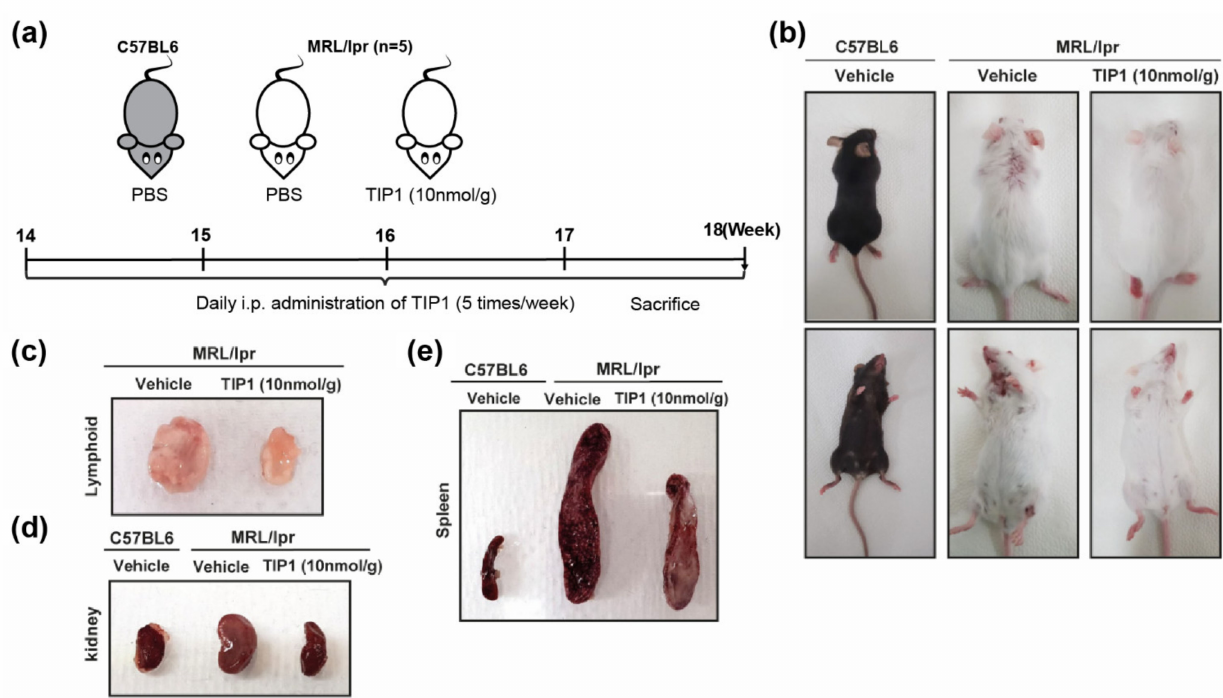
Figure 1. The dramatic inhibitory effect of Toll-like receptor inhibitor peptide 1 (TIP1) on systemic lupus erythematosus (SLE) in a mouse model. ( a ) Summary of the experimental validation of the inhibitory effect of TIP1 on SLE in a lupus- prone mouse. ( b ) Images of the whole body of female lupus-prone mice (MRL/ lpr ) and age- and sex-matched controls (C57BL/6J). Ameliorative effects of TIP1 on inguinal lymphoproliferation ( c ), nephromegaly ( d ), and splenomegaly ( e ). PBS, phosphate-buffered saline. n = 5